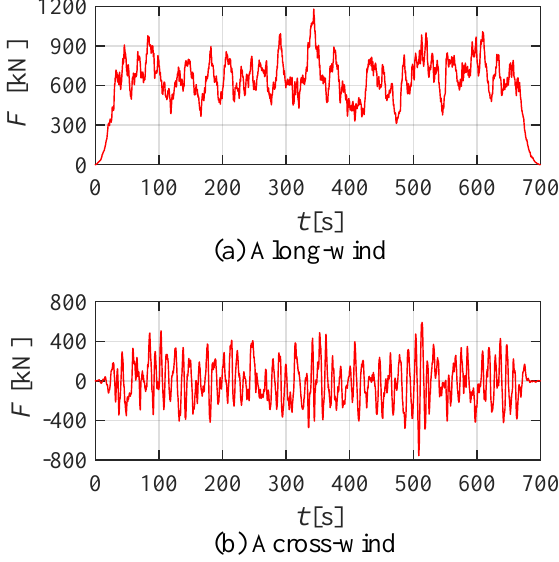
Figure 10. Time history of 1st modal